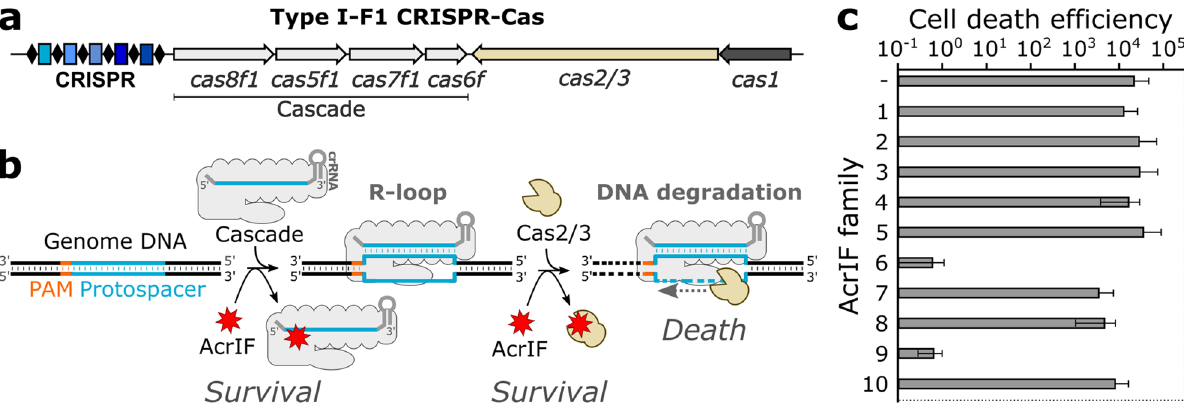
Figure 1. Inhibitors of Aa-CRISPR-Cas system. ( a ) Schematic representation of the Aa-CRISPR-Cas locus composed of six cas genes and CRISPR locus. Cascade genes are underlined. ( b ) Rescue assay by AcrIF. The E. coli genomic DNA was targeted by the Cascade complex forming the R-loop, which triggered the Cas2/3- mediated DNA degradation leading to cell death. The cell could survive when the AcrIF blocked the action of either Cascade or Cas2/3. ( c ) In vivo inhibition of Aa-CRISPR-Cas by the AcrIFs. Representatives from the AcrIF1-10 families were co-expressed with the Aa-CRISPR-Cas system either targeting or non-targeting the E. coli genome. Empty vector (–) was used as a control. The ratio of transformation efficiencies of non-targeting and targeting guides was expressed as cell death efficiencies. Error bars represent standard deviations of average in at least three separate